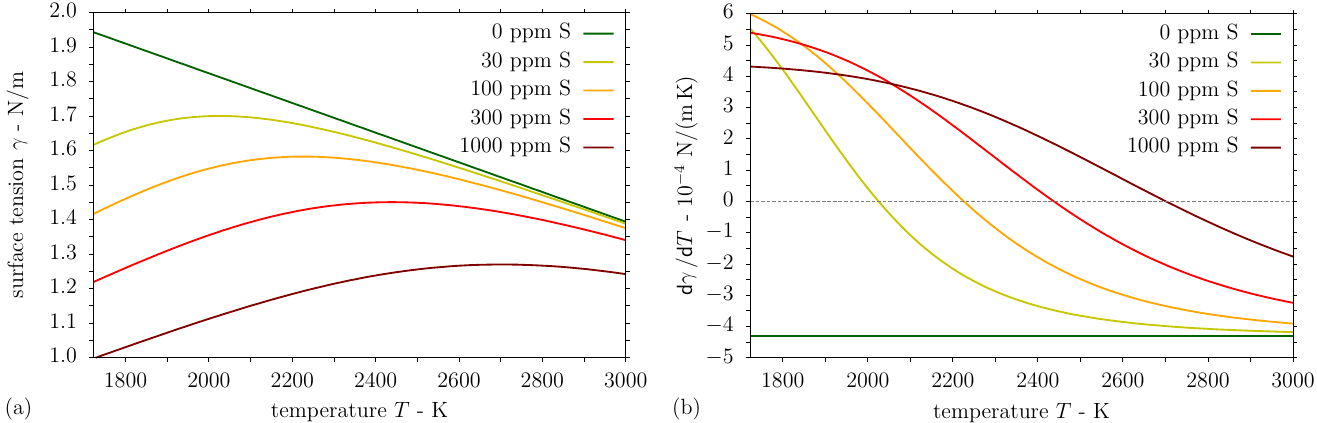
Figure 3. Temperature-dependent ( a ) surface tension and ( b ) its temperature derivative for liquid steel with different sulphur